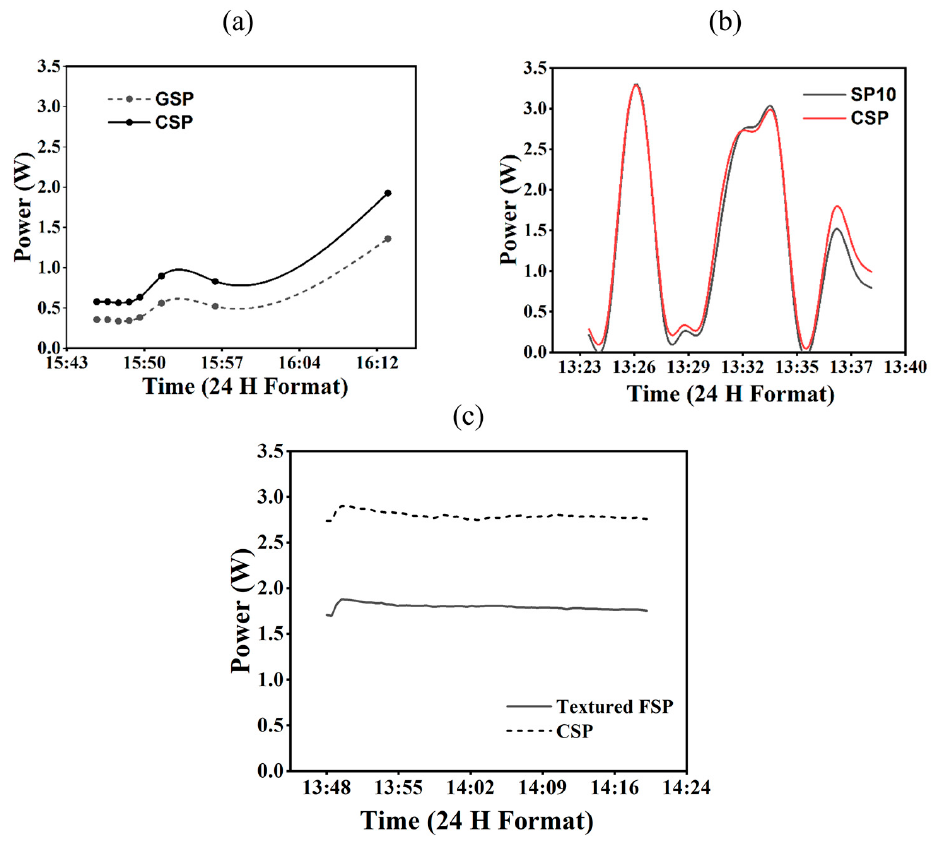
Figure 9. Power production of the different solar modules at a resistance value of 80 Ω ( a ) GSP, ( b ) SP10, and ( c ) textured FSP.